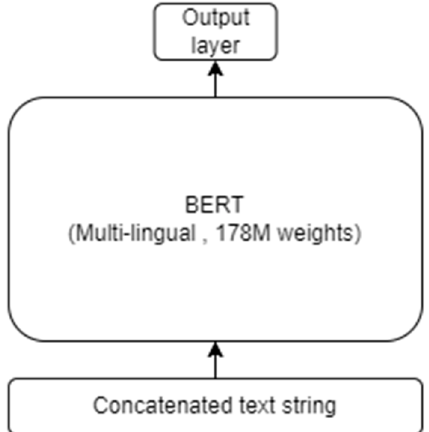
Figure 3. Network architecture, classification model based on transfer learning using BERT.